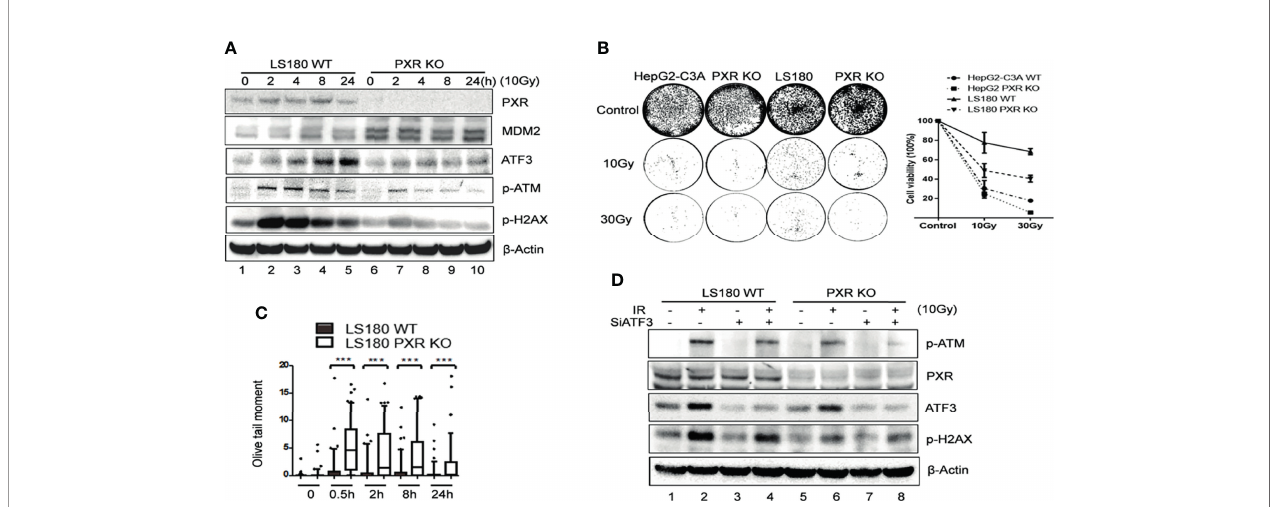
FIGURE 6 | Knockdown of PXR expression impaired ATM activation by IR. (A) IR-induced ATM activation and phosphorylation of downstream substrates were repressed in PXR knockout LS180 cells. Wildtype LS180 cells or PXR KO cells were irradiated (10 Gy), and then subjected to Western blotting using the indicated antibodies. (B) PXR promoted cell viability of LS180 cells against irradiation. Cells were irradiated and subjected to colony formation assay in 60-mm dishes in triplicate. The colonies in the well were counted by Image J and quanti fi ed in the right panel. DNA lesions were accumulated in PXR knockout LS180 cells after radiation. (C) PXR promoted DNA damage repair. Cells were radiated at a dose 10 Gy, and then used for neutral comet assays at the indicated time after radiation. *** p < 0.001, compared with the control, MannWhitney U-test. (D) PXR promotes ATM signaling through regulating ATF3. LS180 wildtype or PXR KO cells were transfected